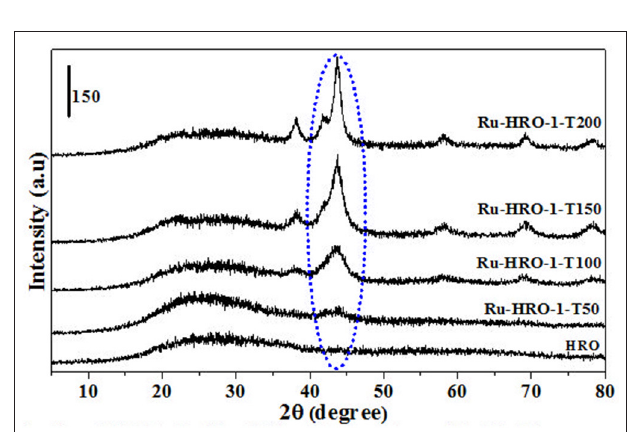
FIGURE 3 | Reduction of HRO to Ru(0) at different temparatures (50–200 ◦ C). Reaction conditions: 25mg of HRO in 40mL of H 2 O, 20 bar H 2 , 10min.